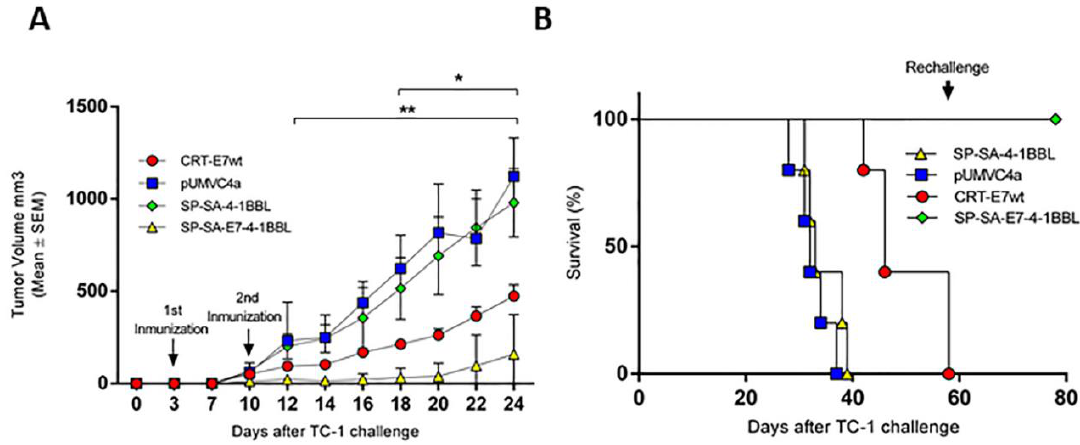
Figure 3. SP-SA-E7-4-1BBL DNA vaccine shows therapeutic efficacy against TC-1 tumor with long- term immunological memory: ( A ) Tumor volume after subcutaneous injection of TC-1 cells in C57BL / 6 mice. At days 3 and 10 after tumor challenge, mice were immunized on shaved abdominal skin with 1 µ g of DNA using gene gun system. Tumor volumes are represented by mean ± SEM. ( B ) Survival graph after TC-1 cell challenge. Mice were euthanized when the tumor volume was higher than 1500 mm 3 . * p < 0.05, SP-SA-E7-4-1BBL compared with CRT-E7wt, SP-SA-4-1BBL and empty